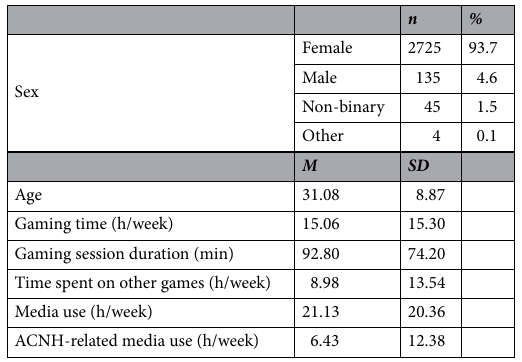
Table 1. Demographic and media-related variables of study sample. Total sample size was N =